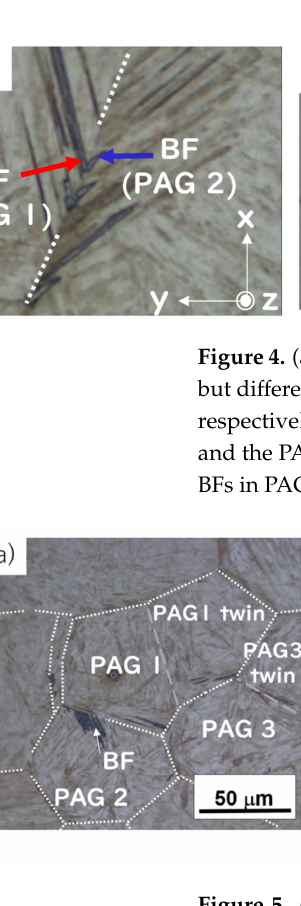
Figure 5. ( a ) The OM image of BFs and ( b ) the corresponding three-dimensional image. ( c ) The formation tendencies of BFs at PAGB edges and planes. (Red: PAGBs where BFs were formed on both sides of the PAGBs, blue: PAGBs where BFs were formed on one side of the PAGBs, gray: PAGBs where BFs were not